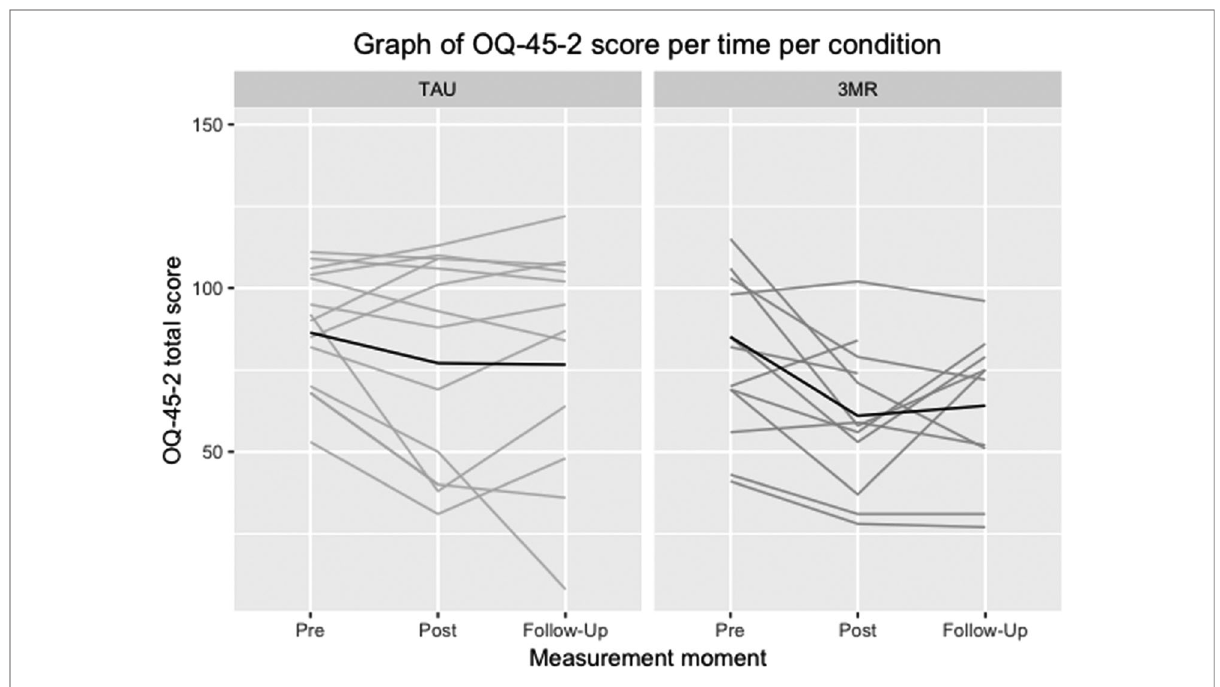
FIGURE 4 Individual patient trajectories over time for the OQ-45-2 in both treatment conditions, with the dark line representing the mean scores.